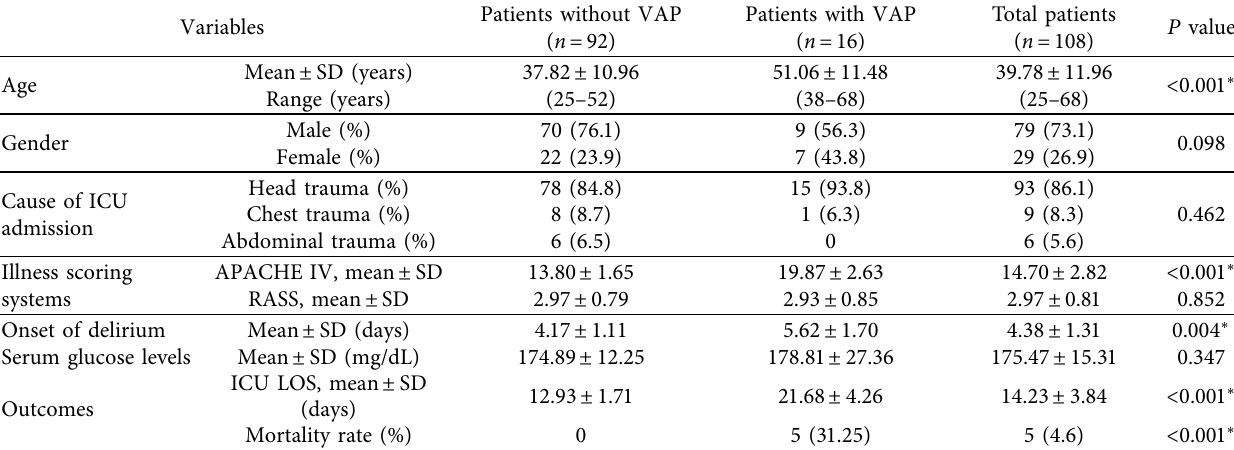
Table 1: Baseline demographic and clinical characteristics and outcomes of patients with delirium according to with and without VAP ( n �